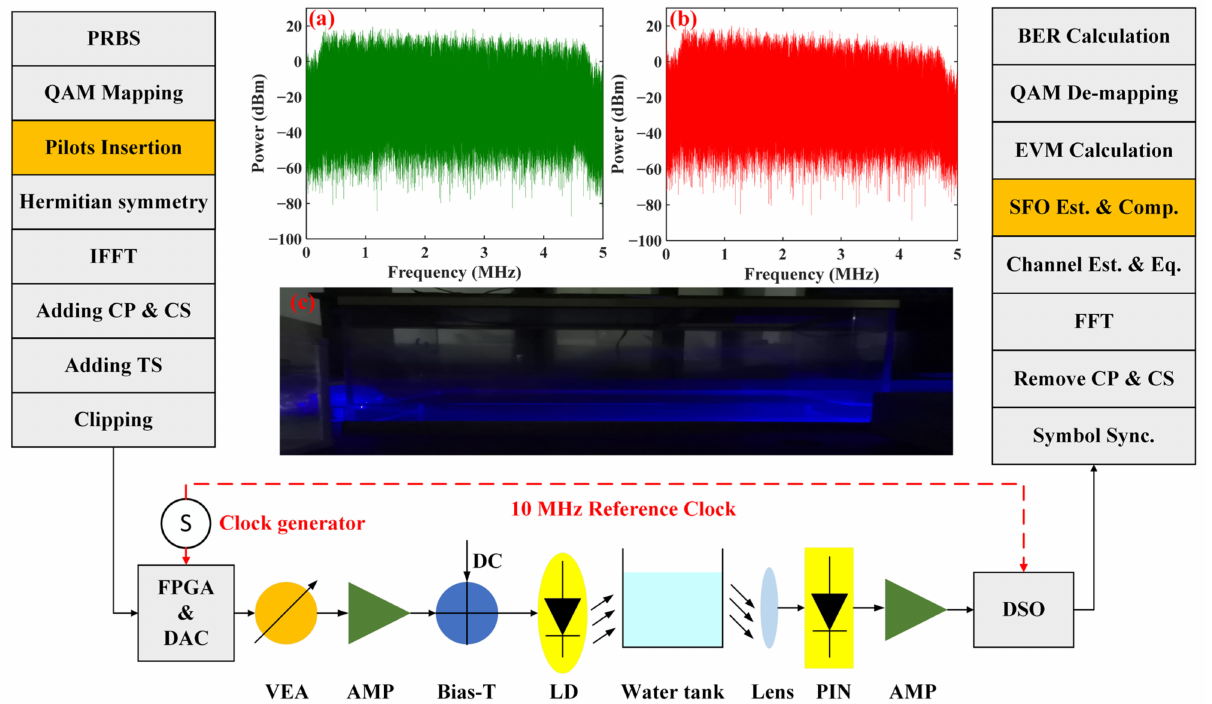
Figure 2. Experimental setup of the UWOC system based on DCO-OFDM. ( a ) The electrical spectra of the transmitted signal; ( b ) the electrical spectra of the received signal; ( c ) the transmission light path of the